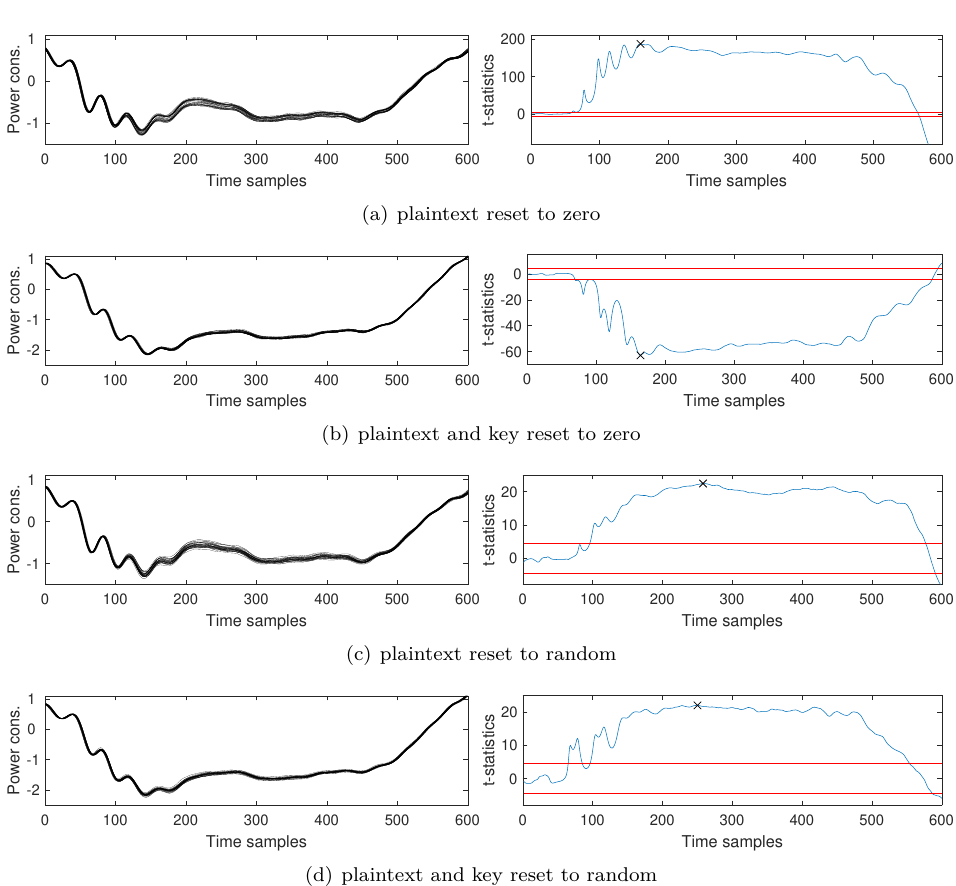
Figure 7: Overlay of 30 sample traces and t -test results using 10 000 traces each for 4 different reset